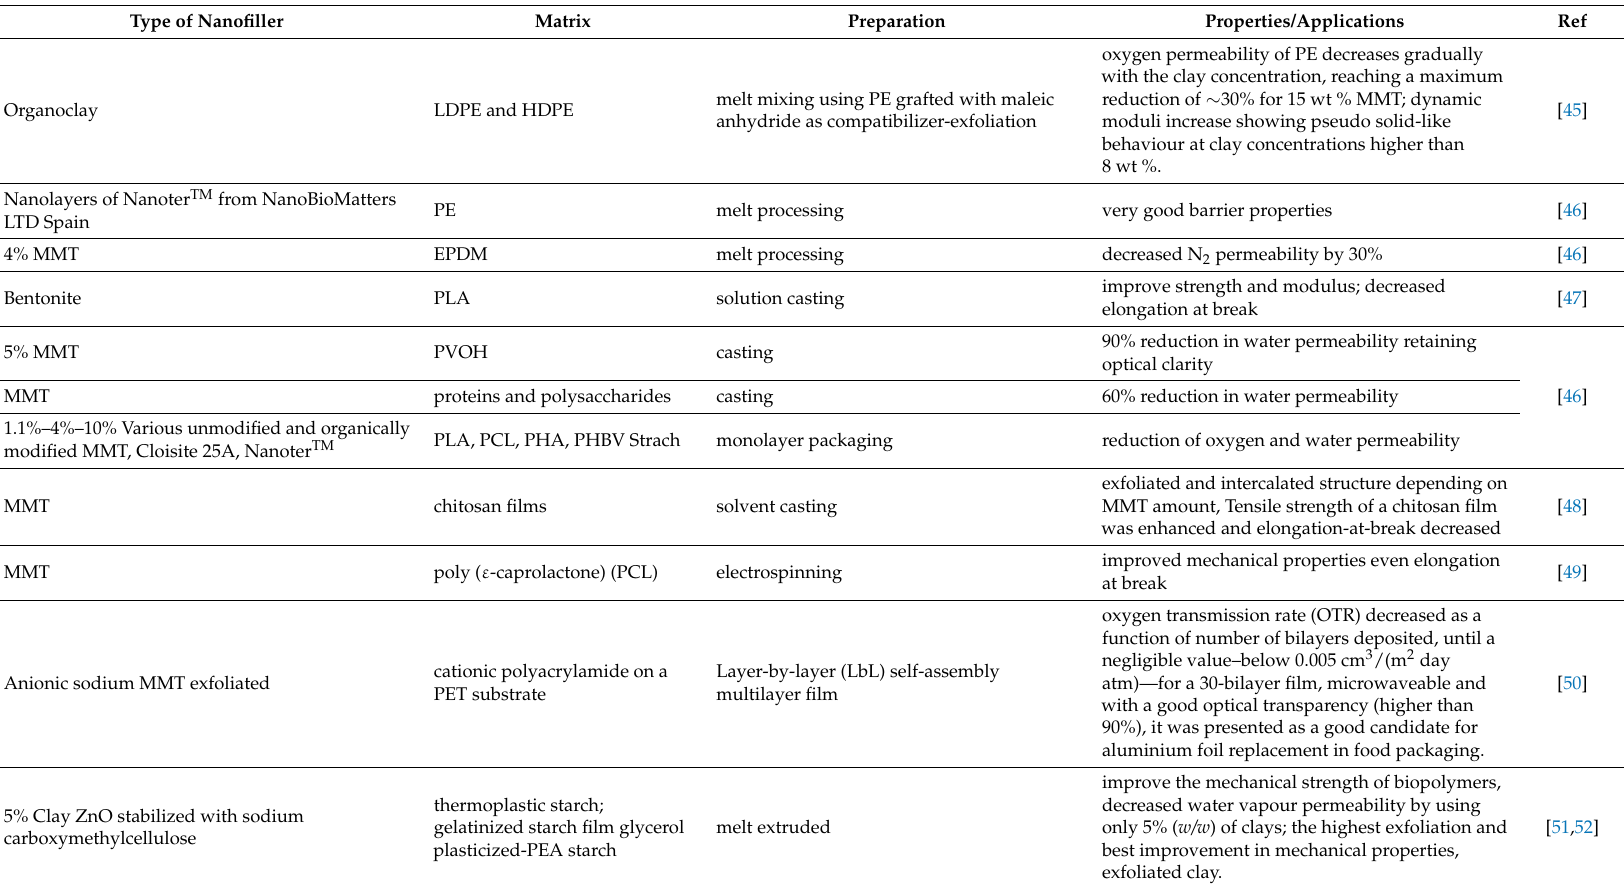
Table 2. Some examples of nanofillers intended to be used in nanocomposites for food packaging (for many examples see also recent reviews on this subject